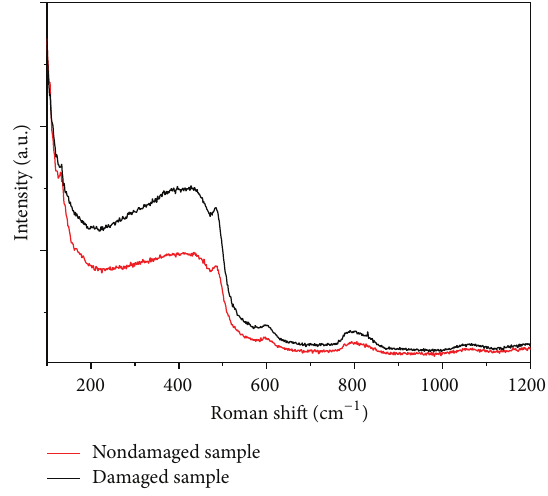
Figure 8: Typical Stokes Raman spectra of fused silica irradiated by UV laser beam with a fluence below LIDT (preirradiated and damage sample).